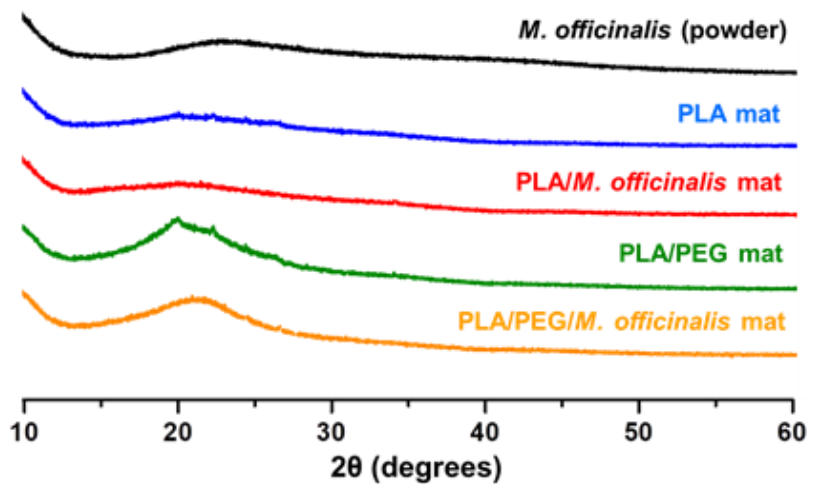
Figure 5. XRD patterns of M. officinalis extract (powder), PLA mat, PLA/ M. officinalis (10 wt%) mat, PLA/PEG mat and PLA/PEG/ M. officinalis (10 wt%) mat.